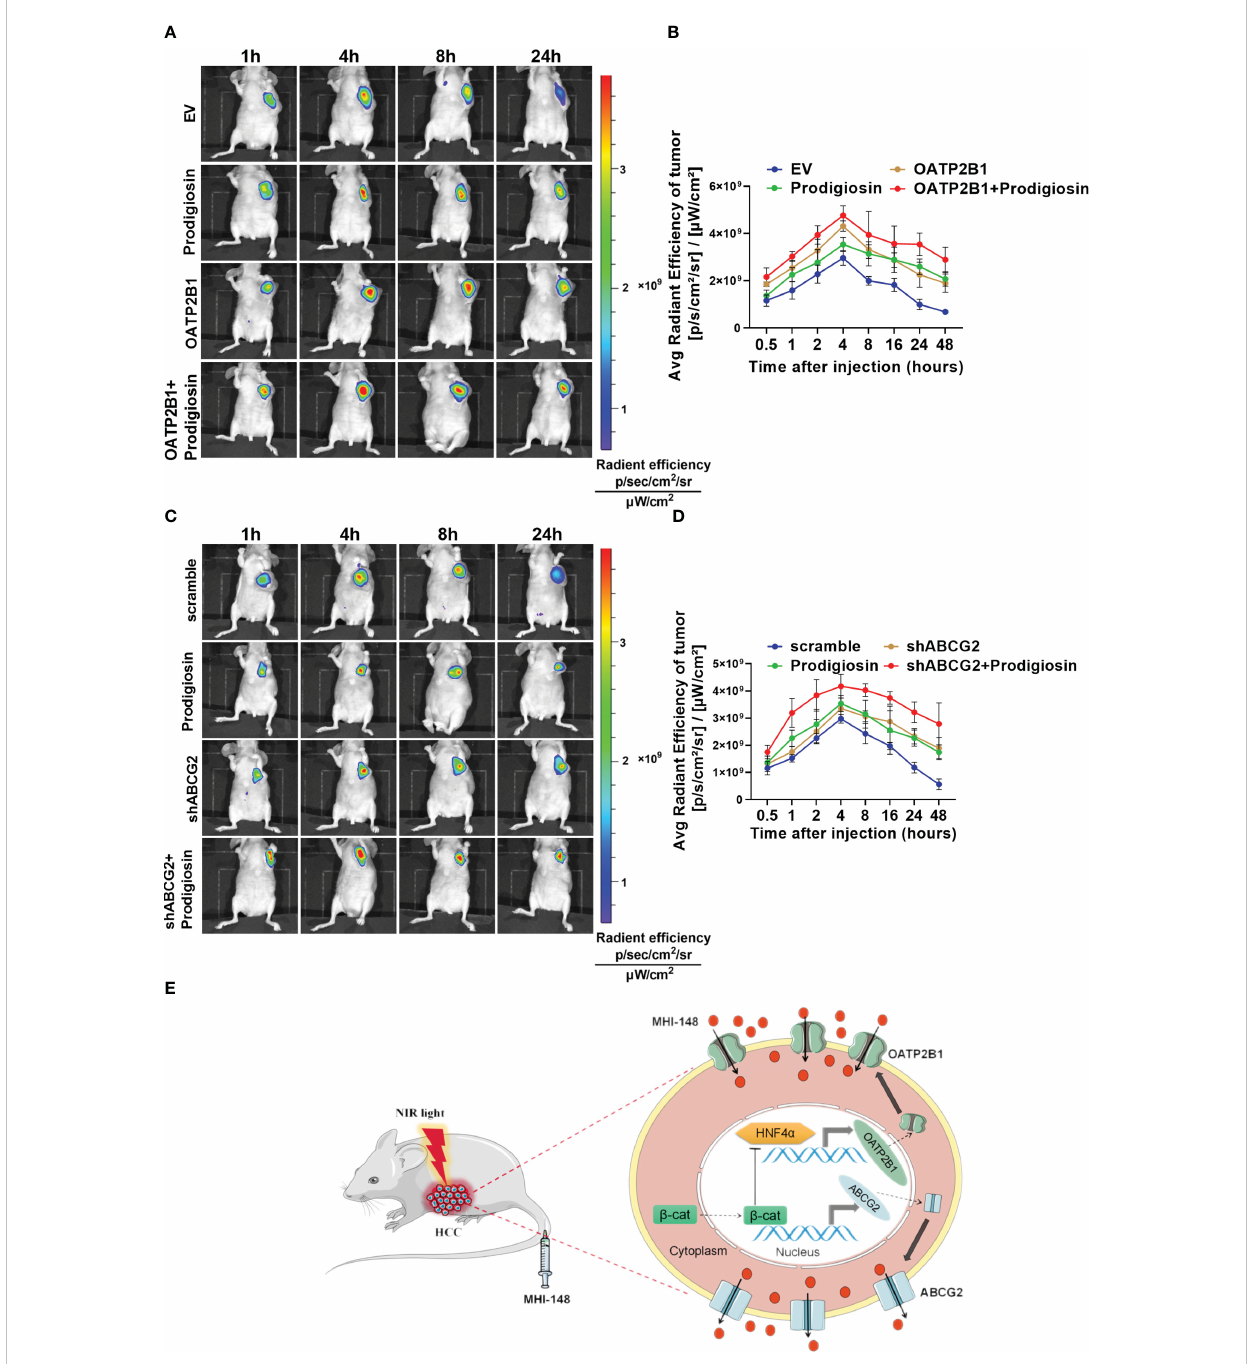
FIGURE 7 The intensity of NIRF imaging is enhanced by inhibiting the b -catenin signaling pathway. (A, C) Time-dependent intensity images of nude mice bearing subcutaneous tumors xenografts of SNU-739 cells treated as indicated after receiving an intravenous injection of MHI-148 (0.75 m mol kg-1). Prodigiosin (5 mg kg-1) was injected twice weekly for 1 week after the tumor volume reached approximately 50 mm 3 . (B, D) Quanti fi cation of MHI- 148 fl uorescence intensity in (A, C) . Data are presented as the ratio of intensity of dye accumulation as normalized to that of blank region (n = 5, mean ± SD). (E) Schematic depicting the underlying molecular mechanisms of membrane transporters-mediated tumor-speci fi c accumulation and retention of MHI-148 in HCC